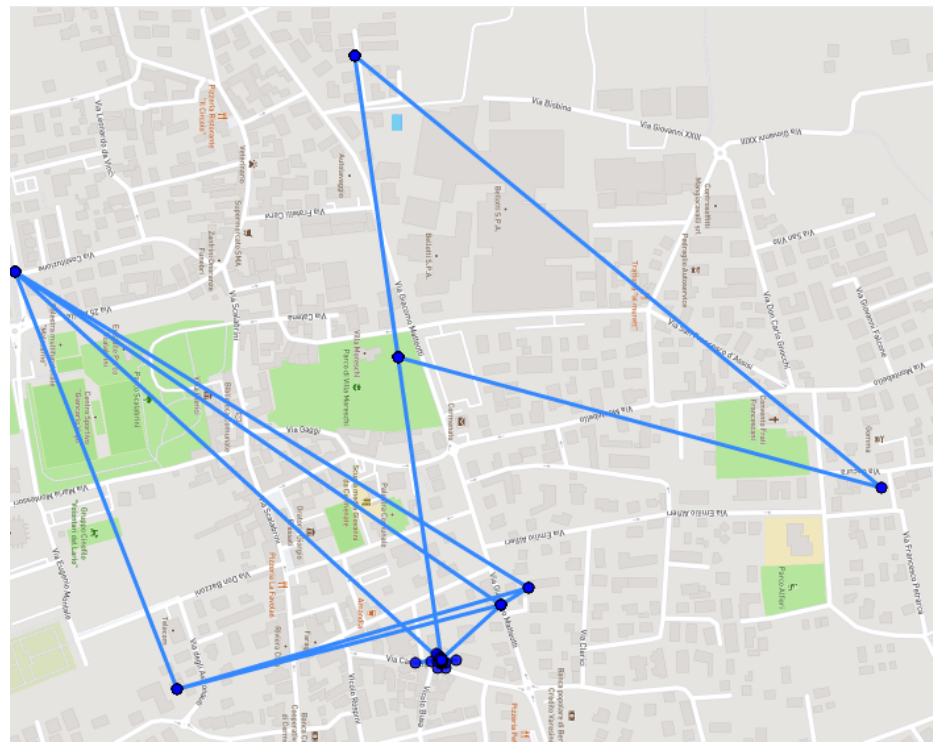
Figure 4. Example of a multi-cluster. All the points on the image are part of the same